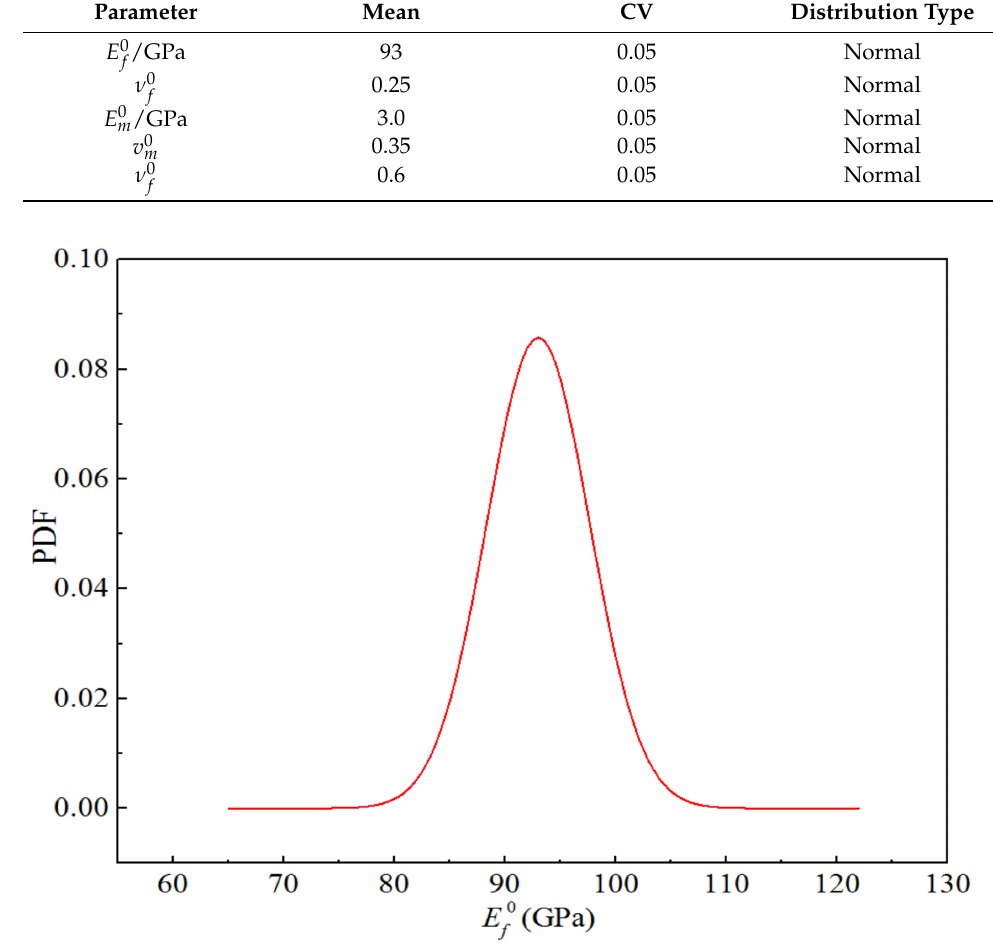
Figure 16. Probability function diagram for the elastic modulus of H-GFRP in the RTD